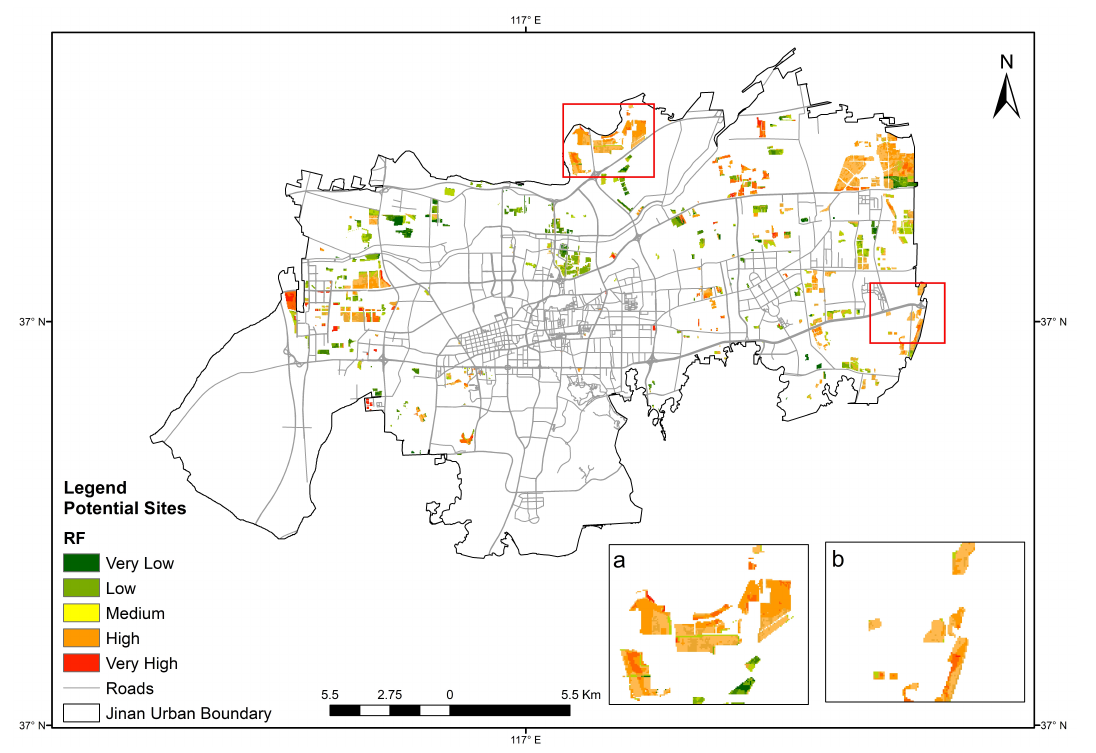
Figure 9. GI development potential sites mapping by RF model: (bottom right) ( a ) North and ( b ) East of Jinan likely to be converted into GI.